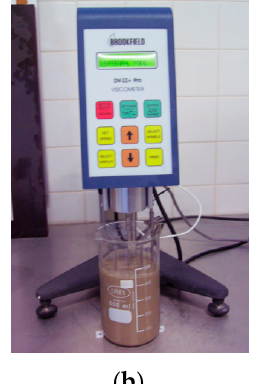
Figure 4. Viscometer: ( a ) Schematic diagram of a Brookfield-type viscometer; ( b ) Brookfield viscometer LV DV-II + PRO with spindle immersed in the sample.